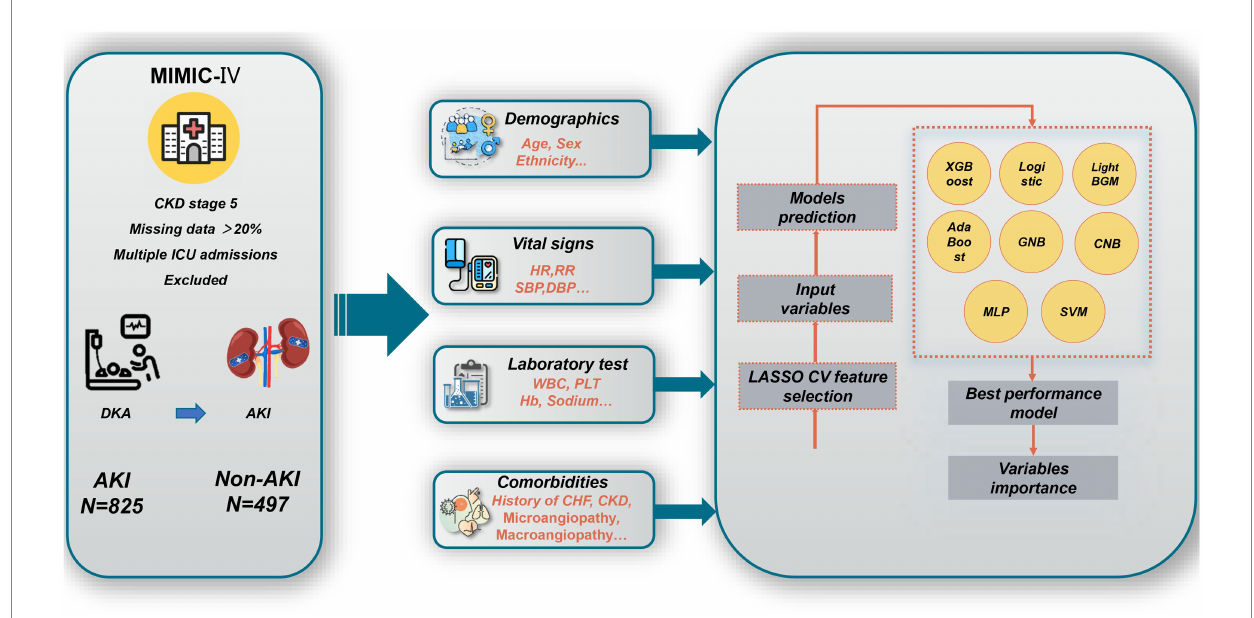
FIGURE 1 Overall flowchart of this study. MIMIC-IV, Medical Information Mart for Intensive Care IV; CKD, chronic kidney disease; ICU, intensive care unit; DKA, v; AKI, acute kidney injury; HR, heart rate; RR, respiratory rate; WBC, white blood cell count; PLT, Platelet count; Hb, hemoglobin; CHF, congestive heart failure; XGBoost, eXtreme Gradient Boosting; GNB, Gaussian Naïve Bayes; CNB, Complement Naive Bayes; MLP, multi-layer perceptron neural network; SVM, support vector machine; LASSO CV, least absolute shrinkage and selection operator